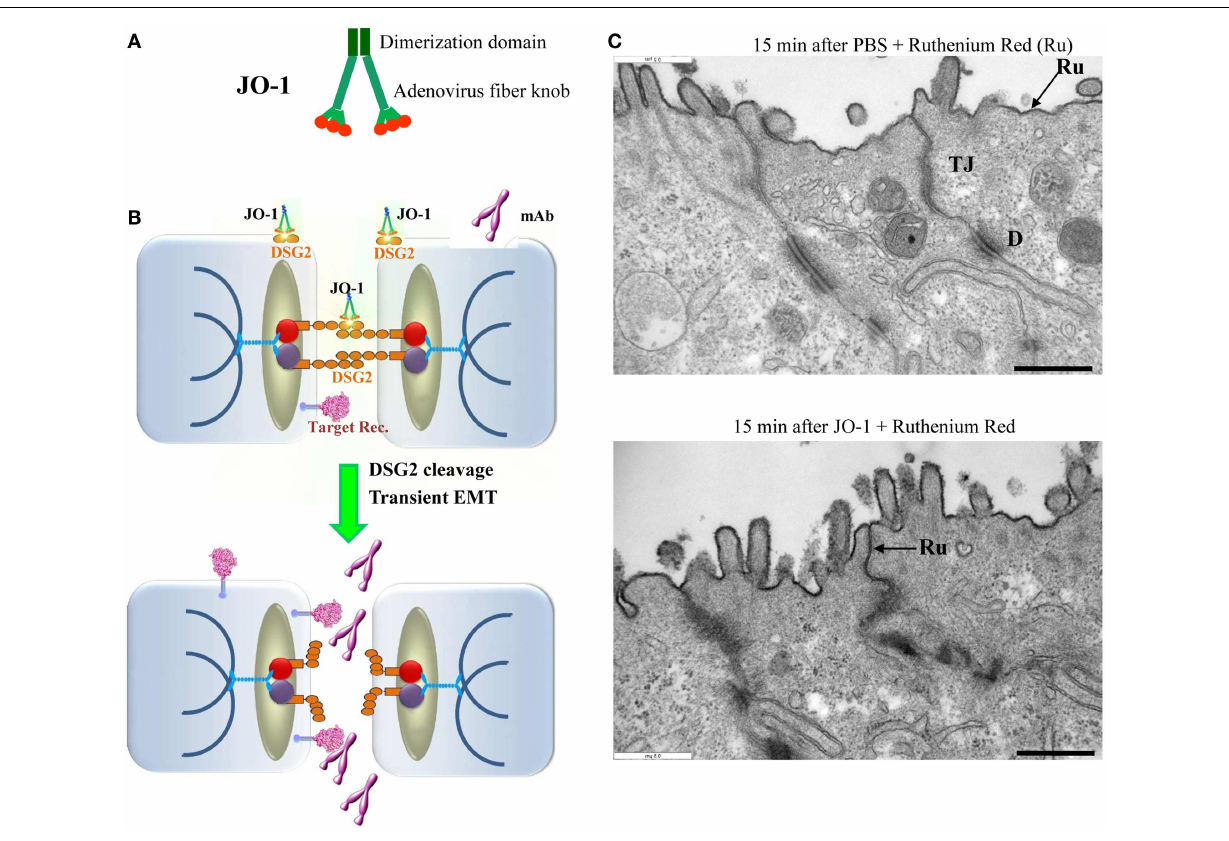
FIGURE 4 | Junction opener 1 (JO-1) . (A) Schematic structure of JO-1 The Ad serotype 3 fiber knob domain and one fiber shaft motif was fused through a flexible linker to a homodimerizing K-coil domain (182).The protein is self-dimerizing and can be purified by His-Ni-NTA affinity chromatography. (B) Mode of action. JO-1 binds with picomolar avidity to DSG2. In epithelial cancer cells, DSG2 is overexpressed and exposed on the cell surface with preferential localization to desmosomes. JO-1 binding to DSG2 triggers cleavage of DSG2 dimers between neighboring cells